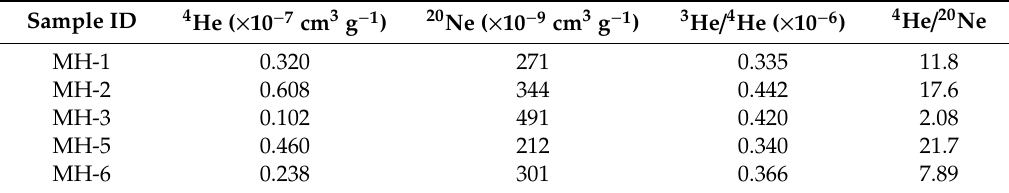
Table 2. Helium and neon isotopic data for Magumsan thermal waters.